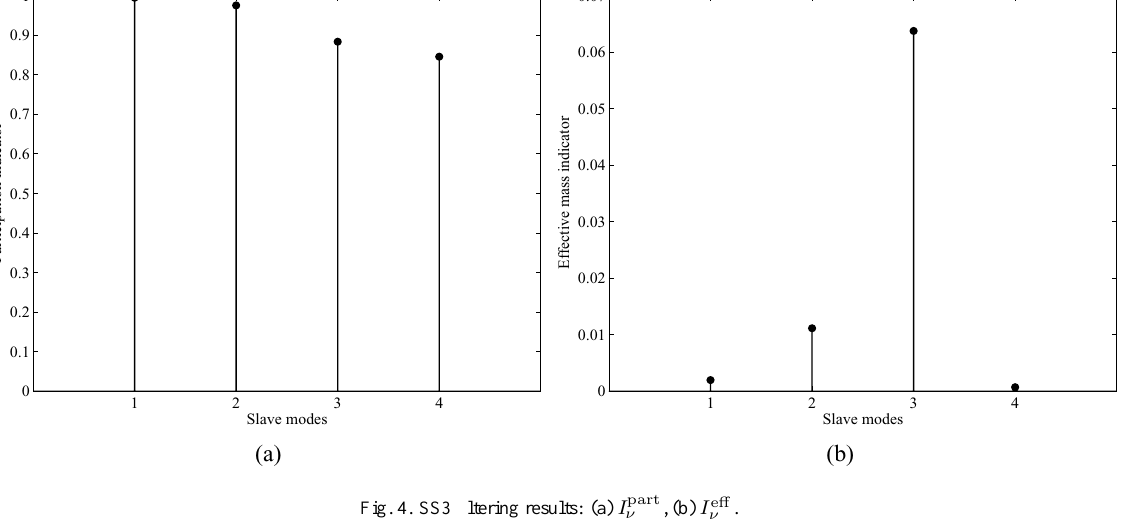
Fig. 4. SS3 filtering results: (a) I part ν , (b) I eff ν .